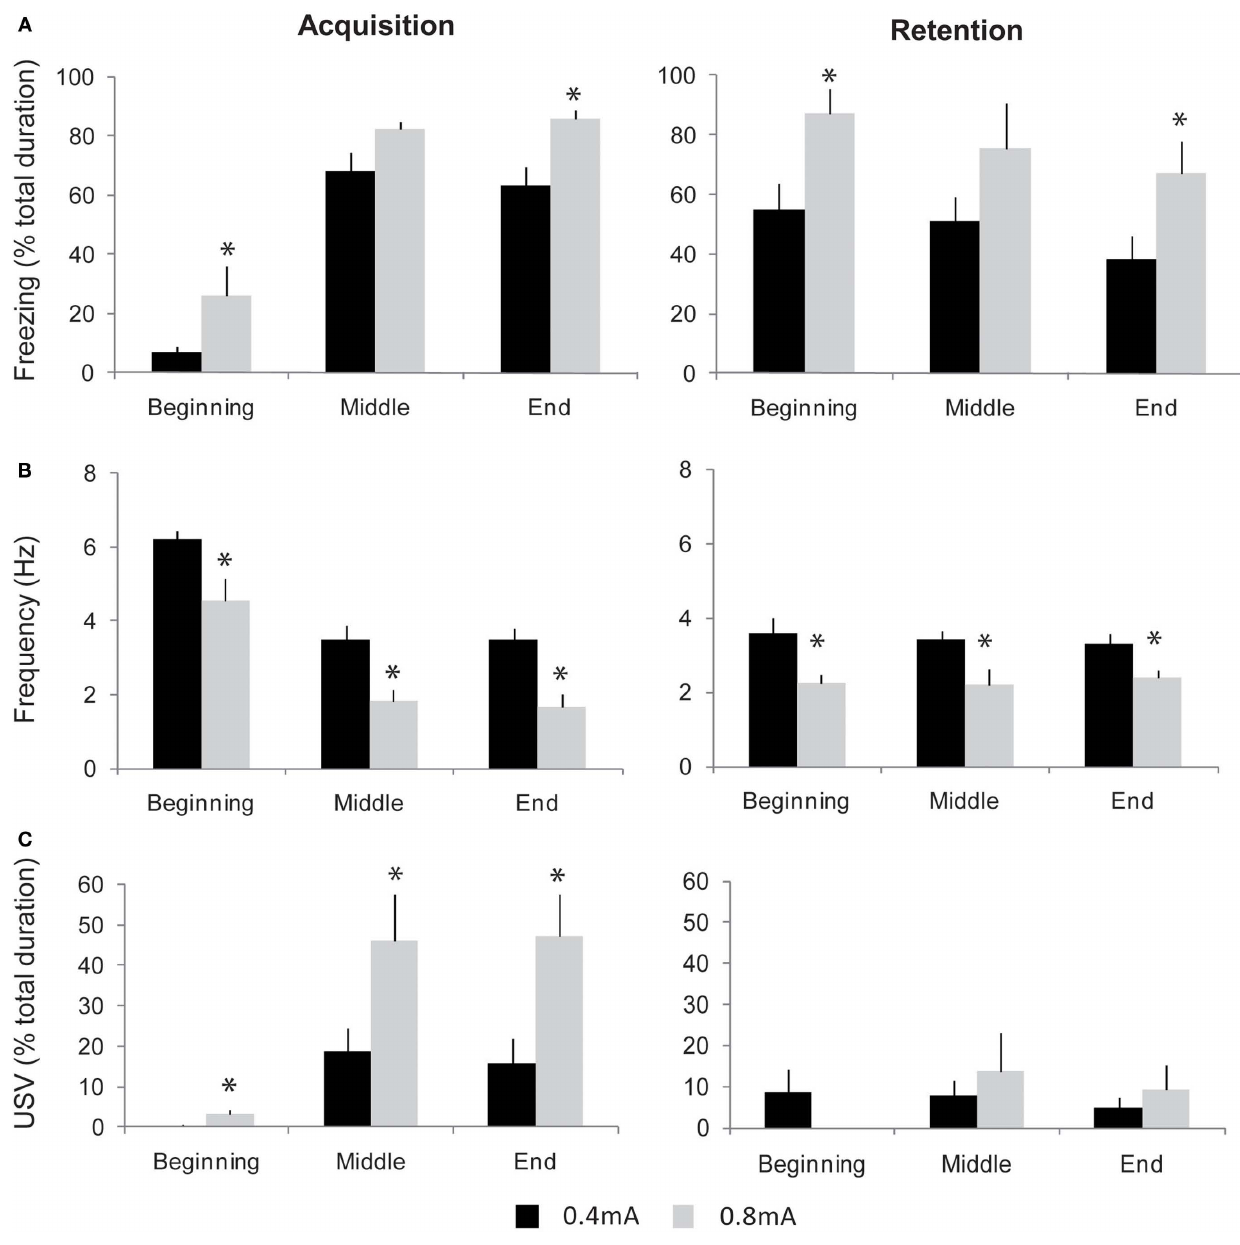
Figure 6 | evolution of freezing, respiration, and ultrasonic vocalizations (uSV) during contextual fear conditioning in two groups of animals trained with different shock intensities: 0.4 versus 0.8 mA. The three parameters were collected at different periods of the acquisition (left part) and retention (right